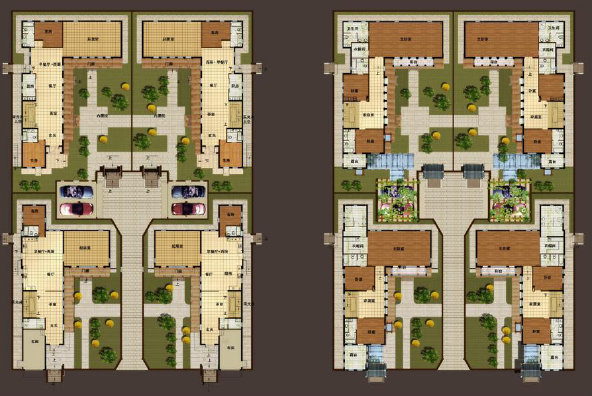
Figure 9. Plans of Beijing Guantang courtyard garden villas, presenting the courtyards/gardens and Western interior circulation system. Source: Beijing Institute of Architectural Design 2014.